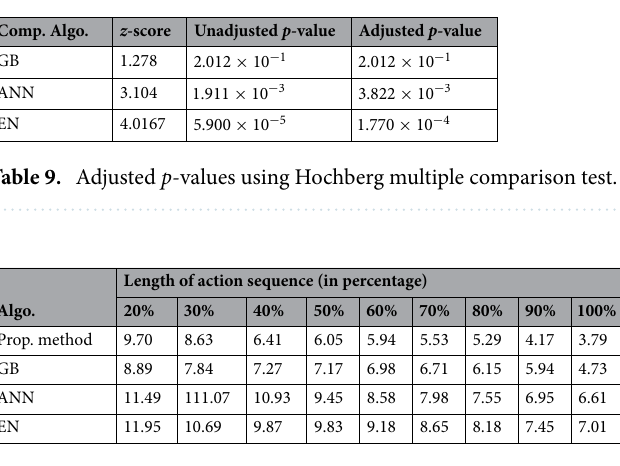
Table 10. MAPE values (with test data) for different competitive methods for different length of action sequence (in percentage).